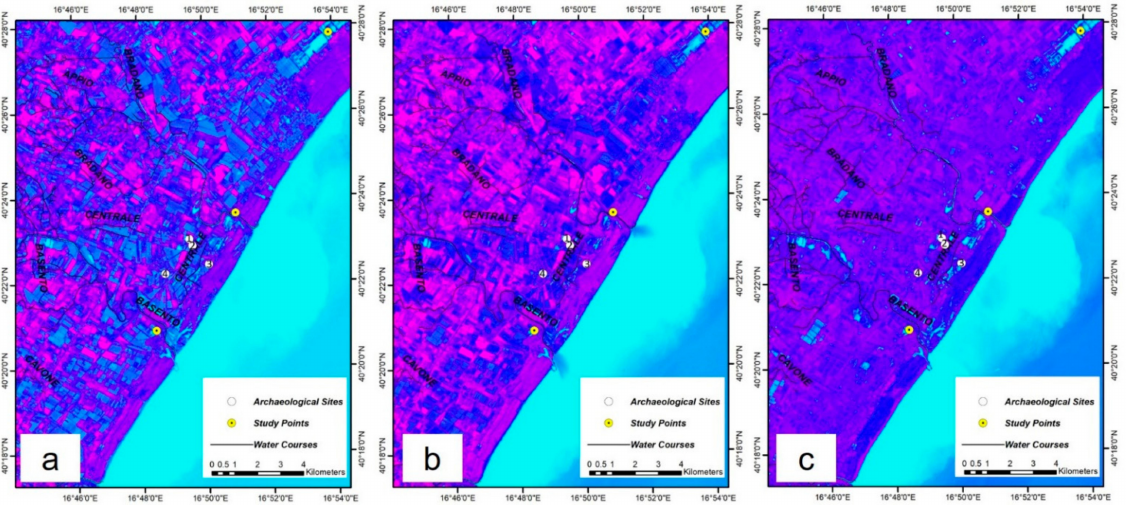
Figure 8. The raster maps of the ( a ) Landsat 8 Normalized Difference Vegetation Index (NDVI), ( b ) Normalized Difference Water Index (NDWI2), and ( c ) Modified Normalized Difference Water Index (MNDWI), for the study area relating to the 1–3 December 2013 flood. Archaeological Sites: 1. Metaponto excavation; 2. Castrum; 3. Ancient remains; 4. Castello